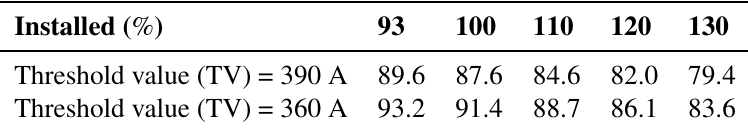
Table 5. Theoretical results for wind energy capturing